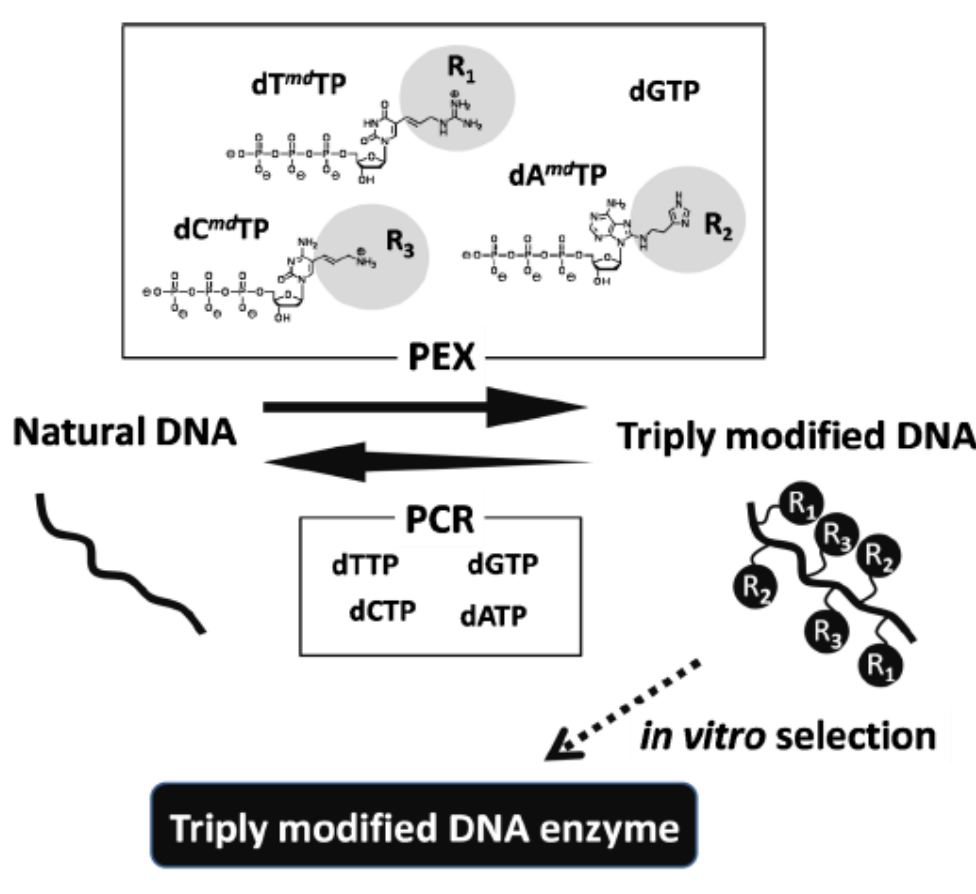
Figure 3. (a) Example of simultaneous incorporation of three different modified nucleoside triphosphates. In in vitro selection, a combination of PEX and PCR was used. (b) Effects of a modified group on nucleotide polymerization. The reaction B is far more inefficient than the reaction